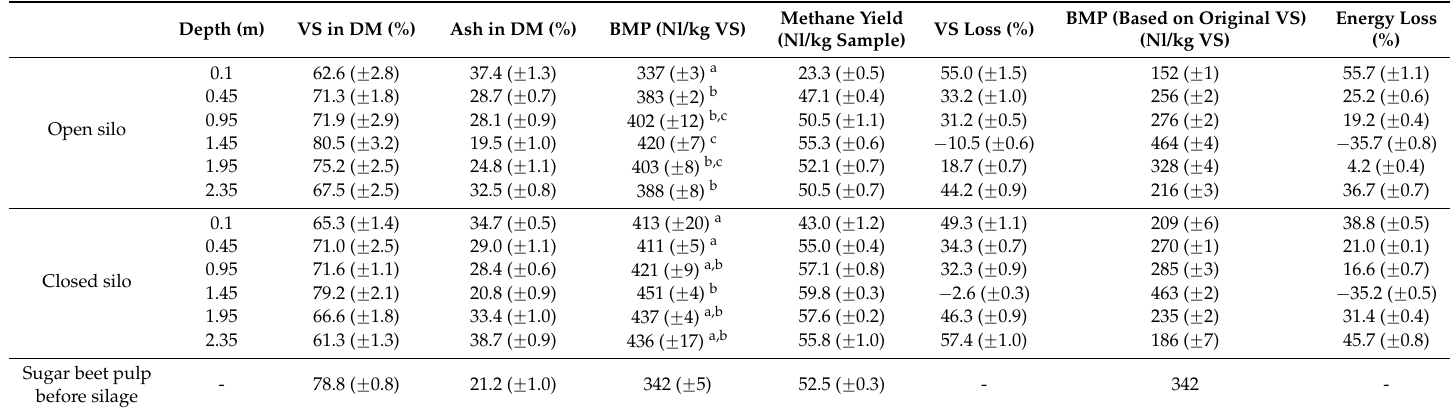
Table 2. VS and energy losses in open and closed silos and methane yield based on original